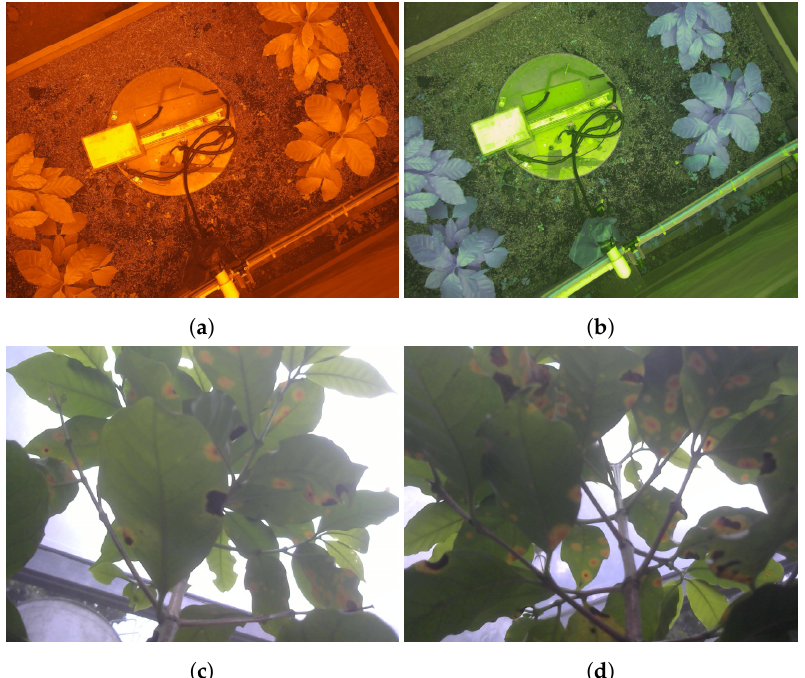
Figure 5. Example of generated files after data collection routine: ( a ) RGN image from lot 1; ( b ) RE image from lot 1; ( c ) RGB image from plant 3, lot 3; ( d ) RGB image from plant 4, lot